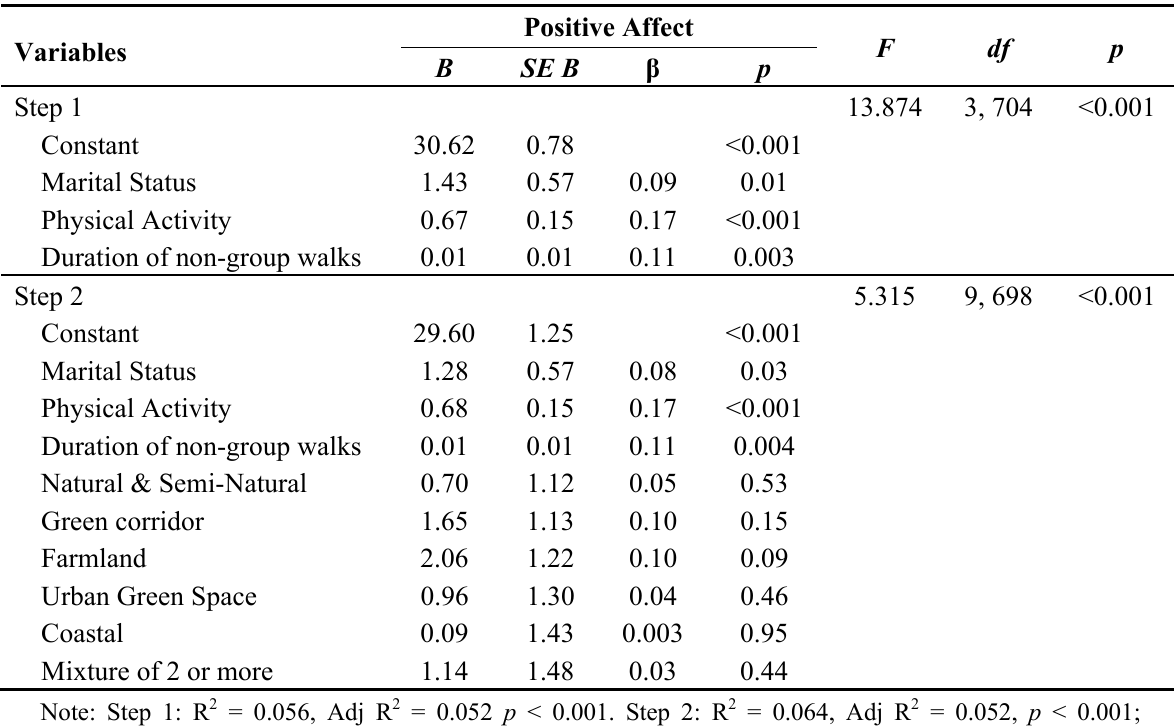
Table 8. Hierarchical regression analyses for variables predicting positive affect for frequent group walkers attending at least once a week ( n =